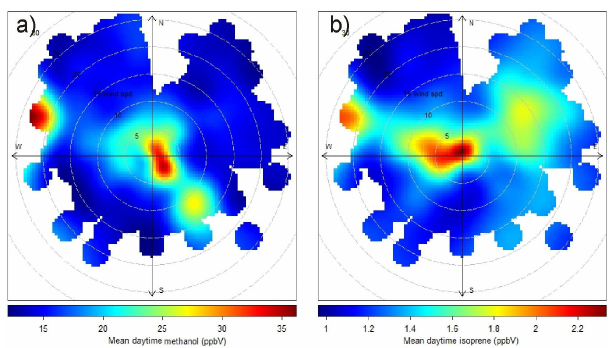
Figure 8. Bivariate polar plots of the (a) daytime methanol data and (b) daytime isoprene data used for constraining location of major point emission